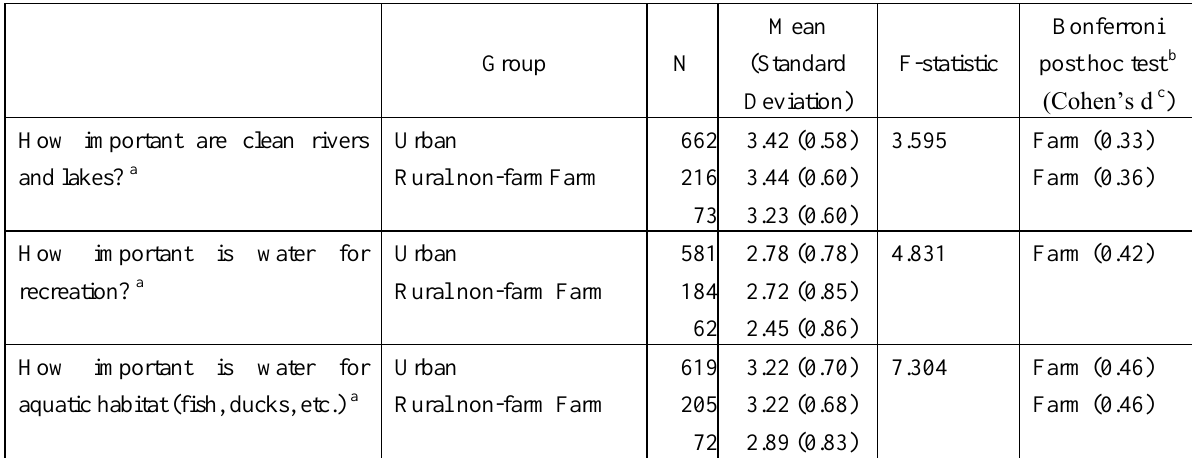
Table 2. Comparisons of differences among urban, rural non-farm and farm perceptions of water resources a